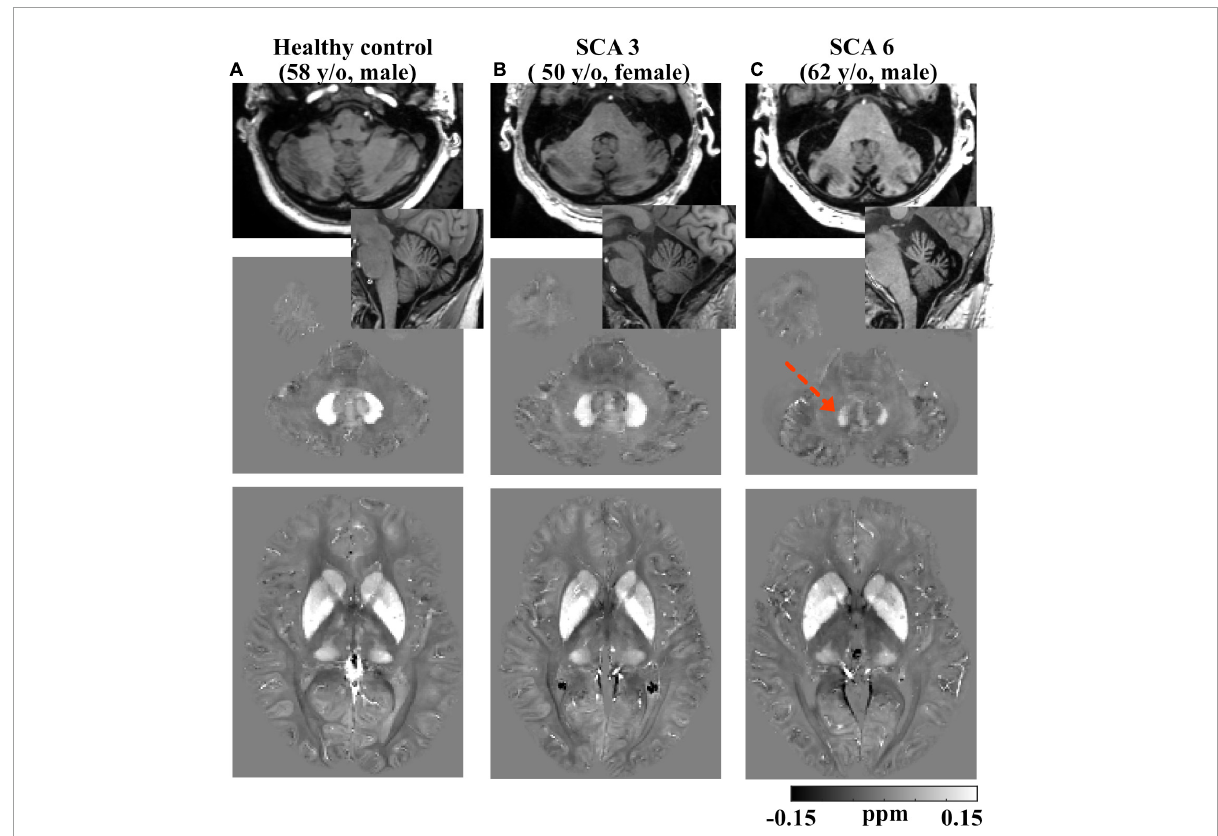
FIGURE2 Example T1-weighted and QSM images. Row 1: axial and sagittal T1-weighted images showing smaller total cerebellar volume in a (62 y/o, M) SCA6 subject (C) vs. a (50 y/o, F) SCA3 subject (B) and a (58 y/o, M) healthy control subject (A) ; slight atrophy in cerebellum was also observed in SCA3. Row 2: axial QSM images showing the dentate. Dotted arrow denotes lower QSM and atrophied dentate in the SCA6 subject. Row 3: axial QSM showing the basal ganglia. Gray scales in QSM images are in the range of (–0.15, 0.15) ppm. All the images are rigidly transformed to MNI space for better comparison of the same anatomical